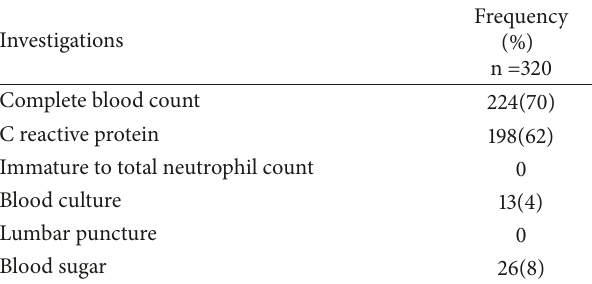
Table 4: Audit of investigations done on admission.